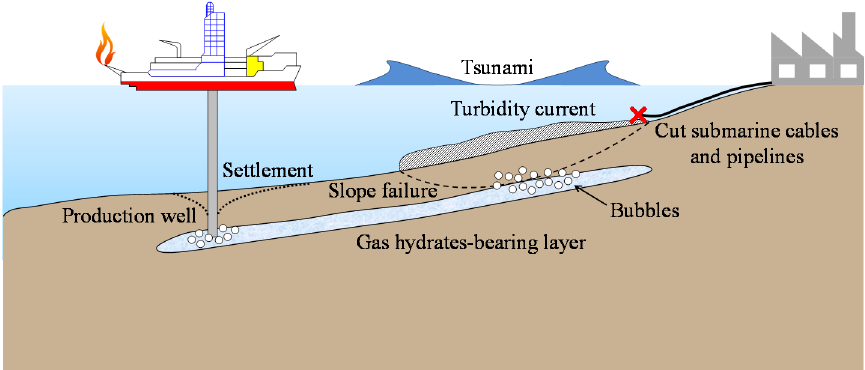
Figure 1. Schematic view of possible hazards in marine sediments induced by gas hydrates